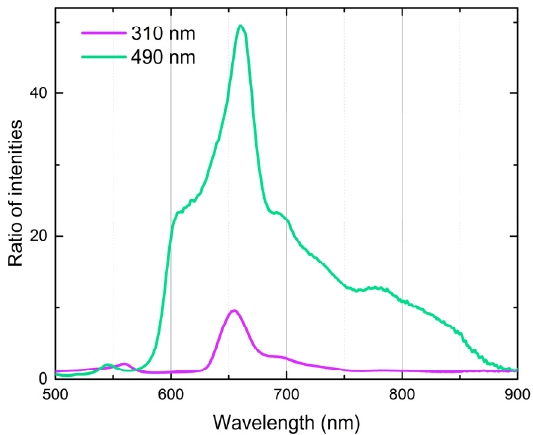
Figure 8. Ratio of fluorescence emission intensities of C 70 in benzene and C 60 in n -hexane (47.6 µ M) under the same excitation conditions (310 and 490 nm). See Figure 6 for conditions.